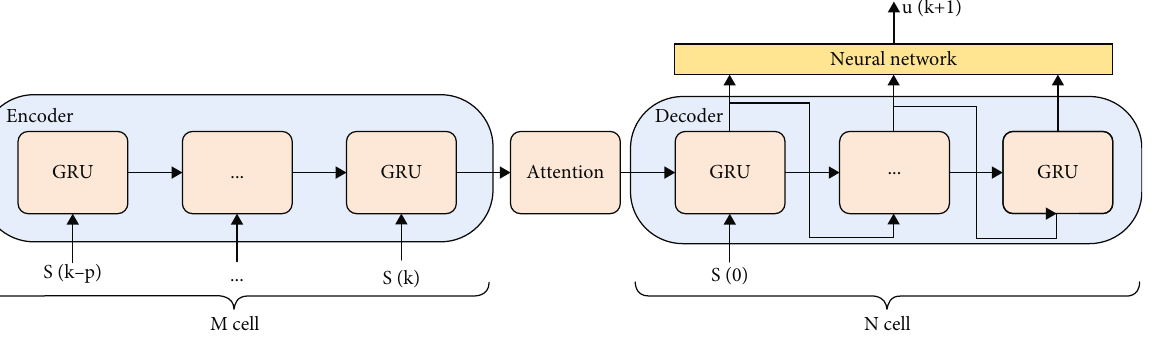
Figure 5: DL-based architecture design.